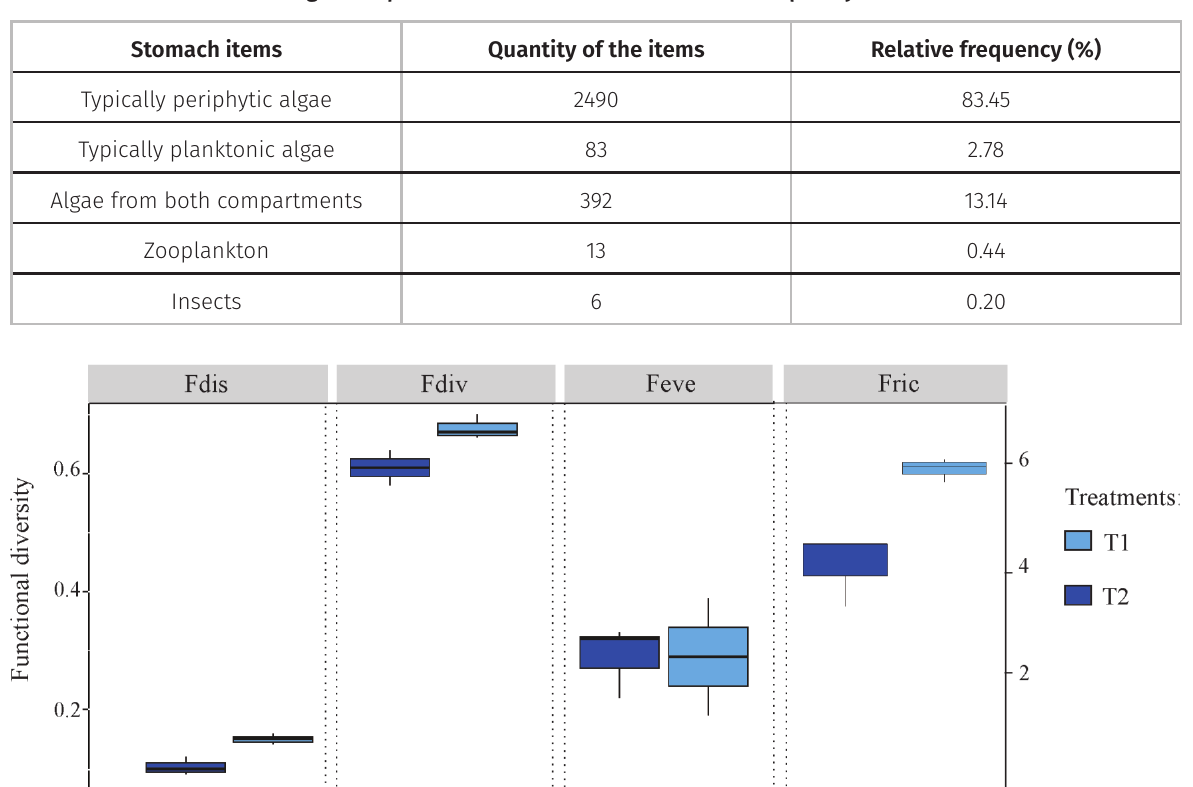
Figure 1. Graphic representation of the first two axes of the PCA (Principal Component Analysis). The points represent the treatments, where left is non-predation (T1) and right is the presence of predation (T2). Only the scores of the first axis were interpreted according to the Broken-Stick criterion. TP = total phosphorus, TDS = total dissolved solids, TN = total nitrogen, Cond = conductivity.